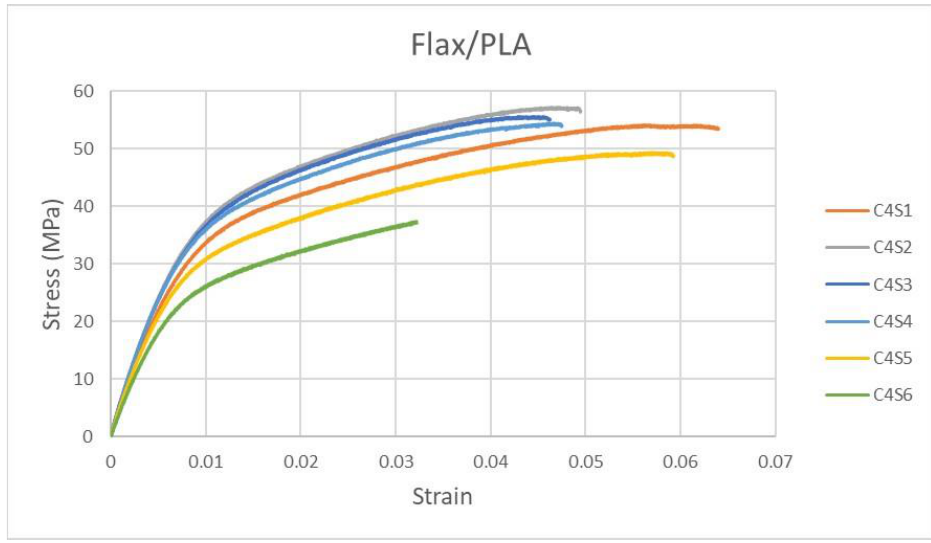
Figure 5. Stress – strain curves of flax/PLA composite. Figure 5. Stress–strain curves of flax/PLA Table 1. Mechanical properties of the nonlinear elastic columns.